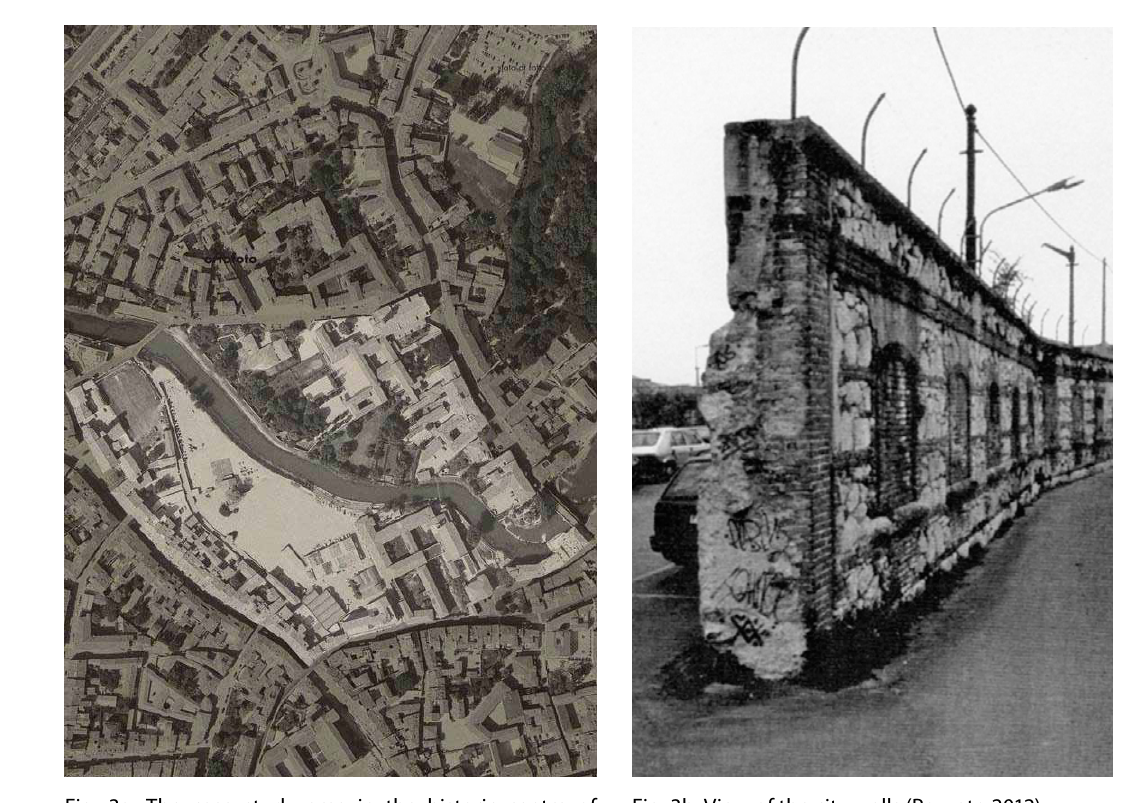
fig. 3a. The case study area in the historic centre of Vicenza (Pozzato 2012)